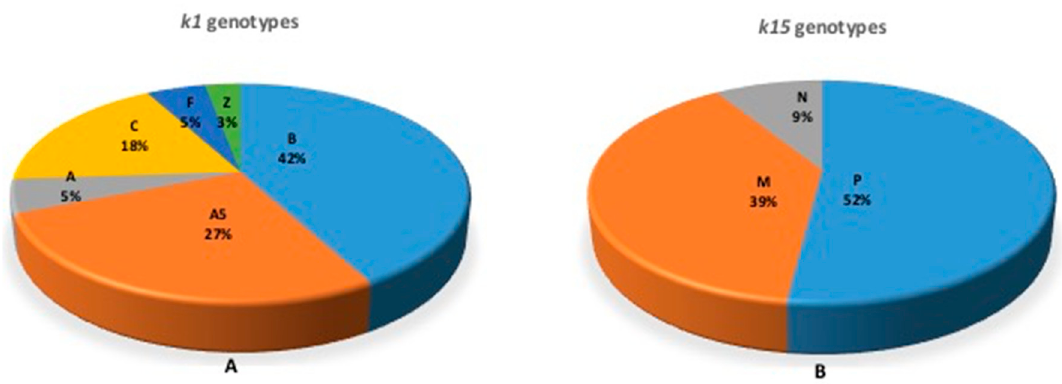
Figure 4. Proportional representation of HHV-8 genotypes in Africa. ( A ) represents K1 genotypes; ( B ) represents K15 genotypes. K1 genotype B is the most prevalent followed by genotype A5, while K15 genotype P is most prevalent genotype followed by genotype M.